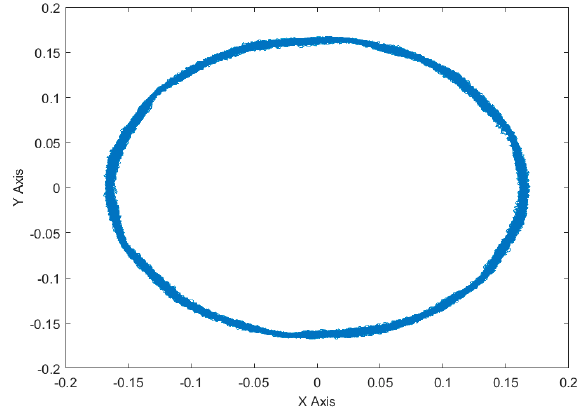
Figure 10. The torque response curves of two control algorithms.